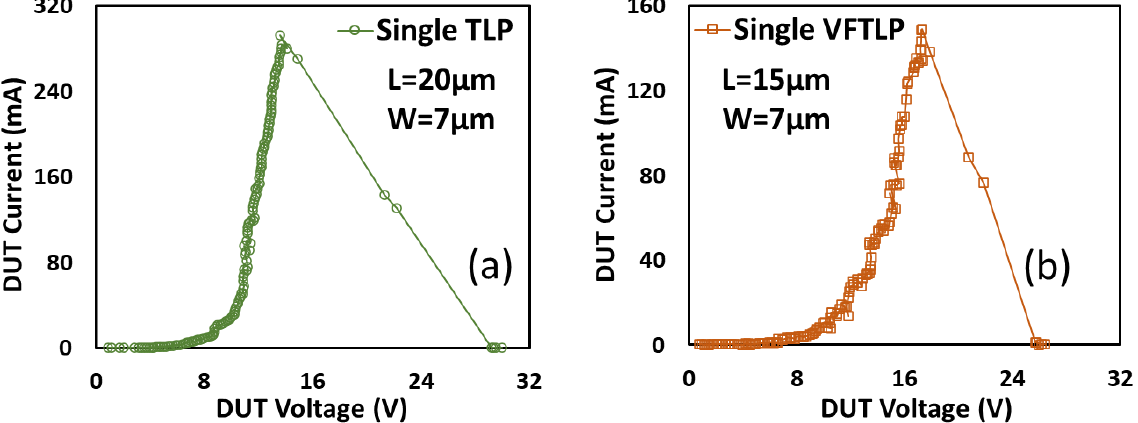
Figure 23. Measurement of single-crystalline gNEMS samples showing robust ESD current-handling capability (I t2 ): ( a ) TLP zapping, and ( b ) VFTLP zapping [44].